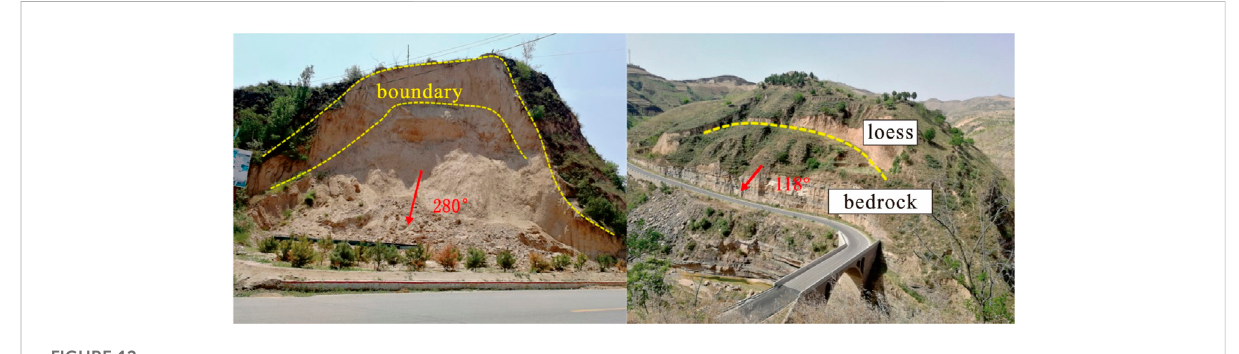
FIGURE 12 Typical shallow landslides triggered by human engineering